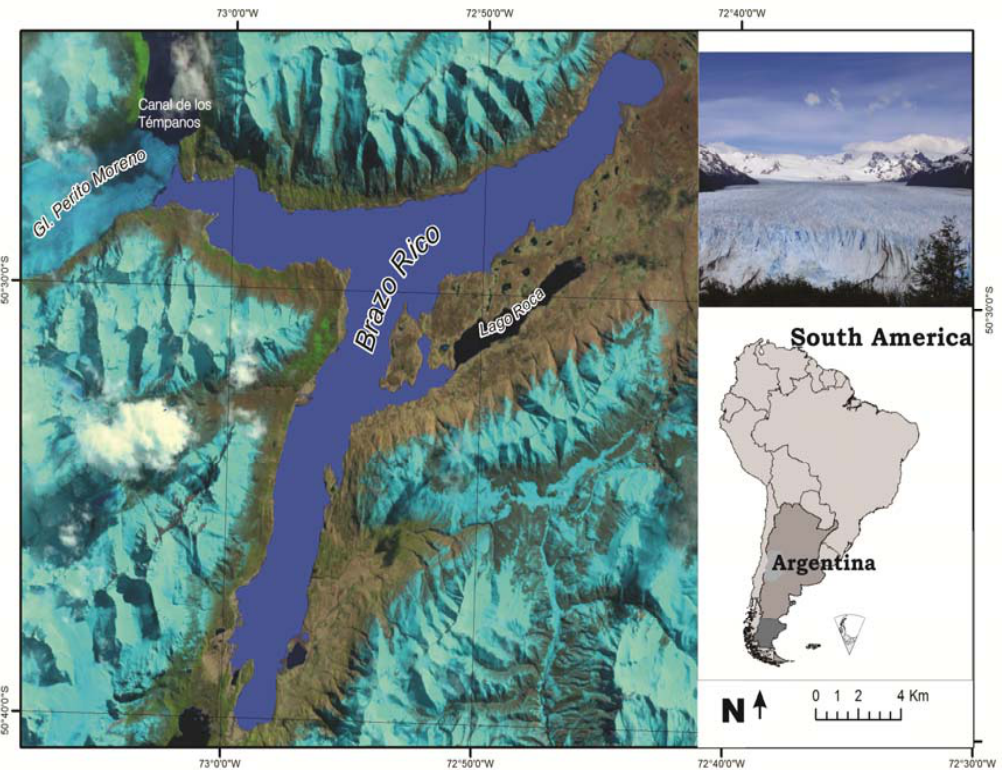
Figure 1. Map of the study area.